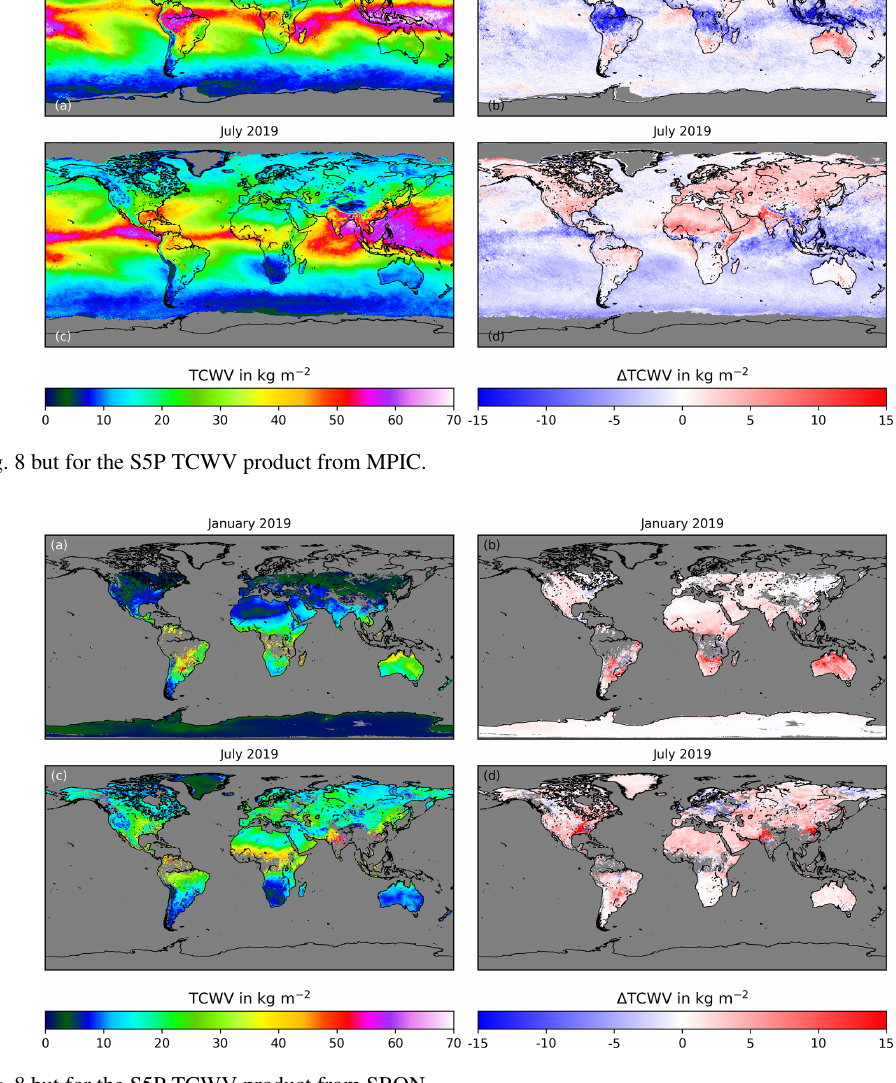
Figure 11. As Fig. 8 but for the S5P TCWV product from